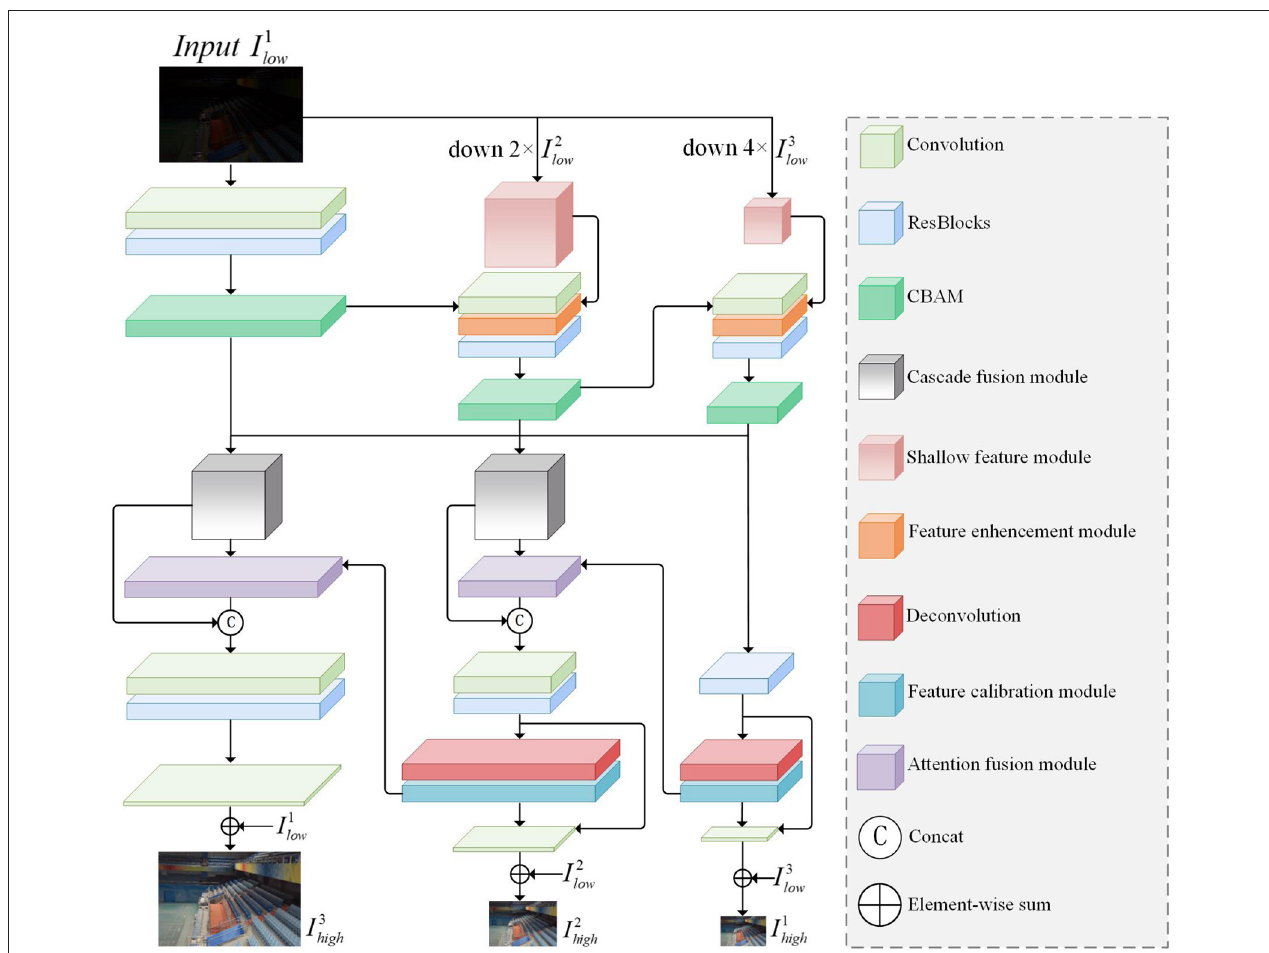
FIGURE 2 | The overall framework of our proposed MSSFNet. The network framework is divided into two parts: the upper part is the encoder part for multi-scale input images and the lower part is the decoder part for multi-scale output images.